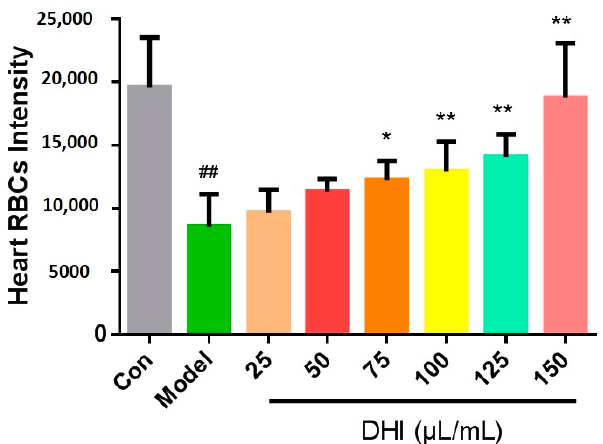
Figure 2. Heart red blood cells intensity in the zebrafish of control group, model group (AA 40 μ M), and DHI group of different concentrations (25–150 μ L/mL). The error bars represent the standard deviation based on ten repeated samples. All data was represented by the mean ± SD, ## p < 0.01, ** p < 0.01, * p < 0.05, n = 10.